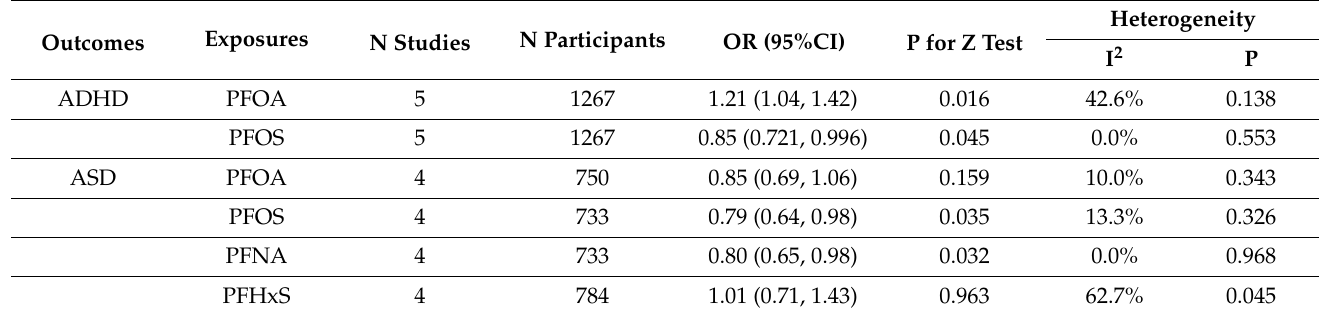
Table 3. Summarized odds ratios for ADHD and ASD associated with polyfluoroalkyl substances concentrations in the highest quartile